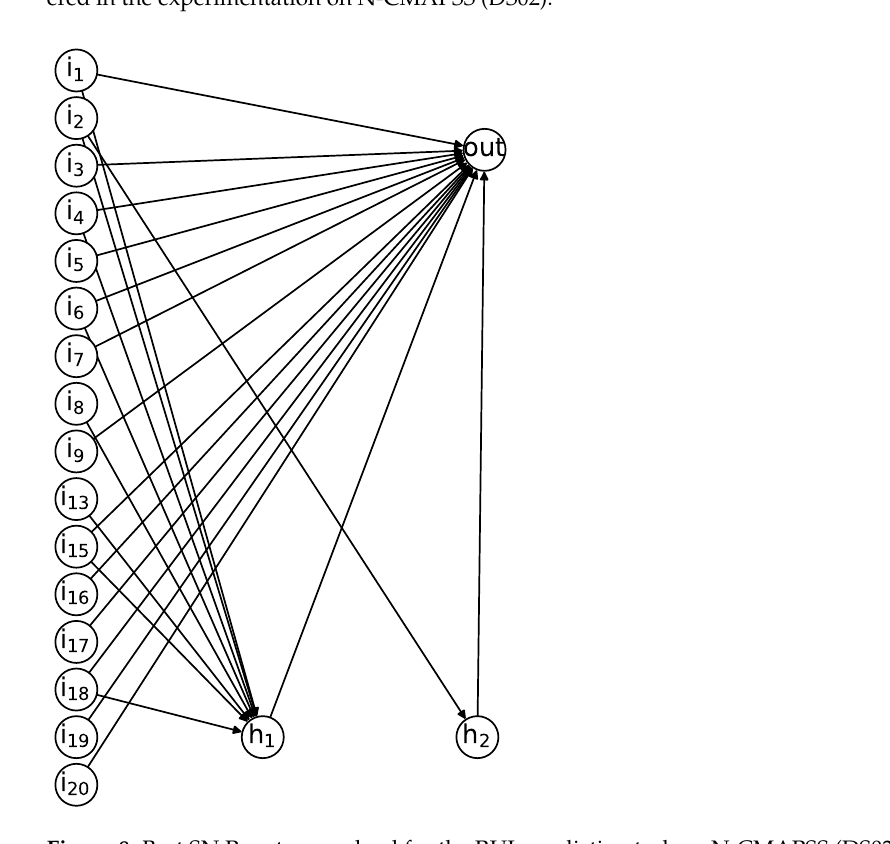
Figure 8. Best SN P system evolved for the RUL prediction task on N-CMAPSS